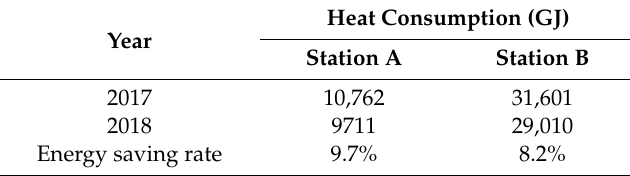
Table 10. The comparison of the energy utilization for station A and station